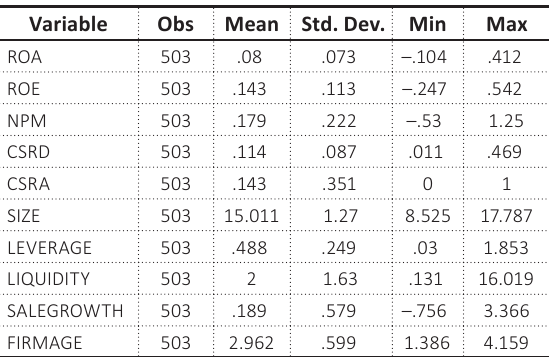
Table 3. Descriptive statistics for mid-cap